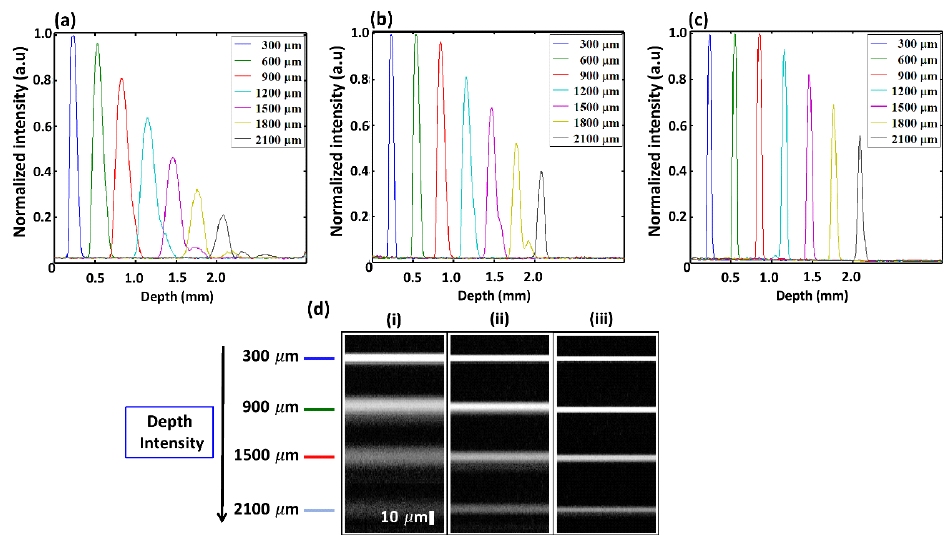
Figure 3. ( a ) Sensitivity roll-off comparison between non-linearized k -domain, ( b )